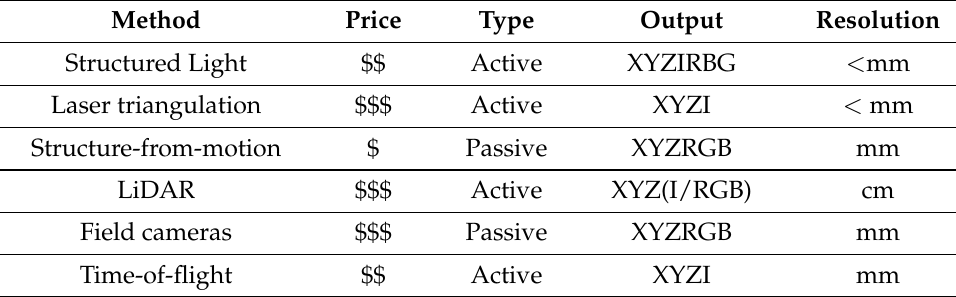
Figure 1. Classification of 3D acquisition methods. Table 1. Comparative analysis of state-of-the-art 3D acquisition